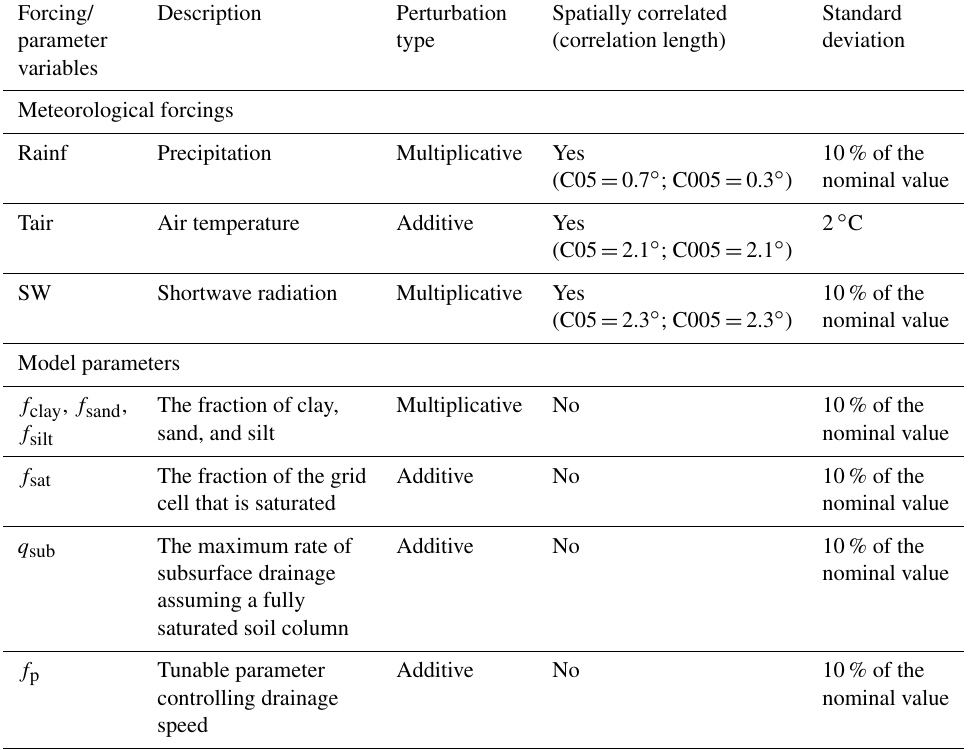
Table 3. Perturbation settings associated with the meteorological forcing data and model parameters. The comprehensive description of model parameters can be found in, e.g., Decker (2015) and Ukkola et al. (2016). The spatial correlation error is also applied to forcing data (fourth column). The correlation length of the 0.5 and 0.05 ◦ CABLE model (C05 and C005) is determined based on covariance analysis (see Sect.